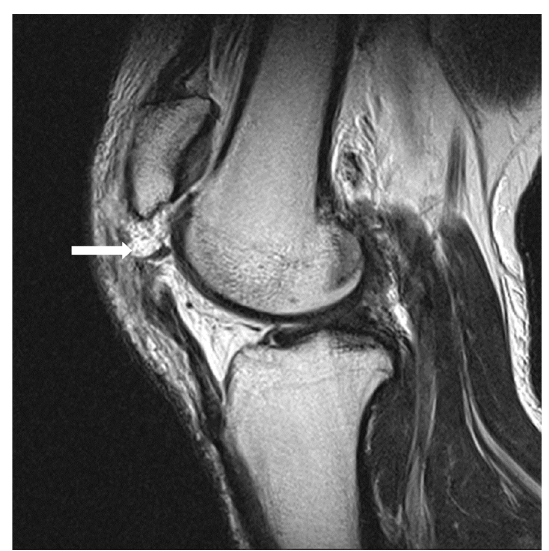
Image 2. Magnetic resonance sagittal T2-weighted image shows proximal patellar tendon rupture (enthesis of the patella)